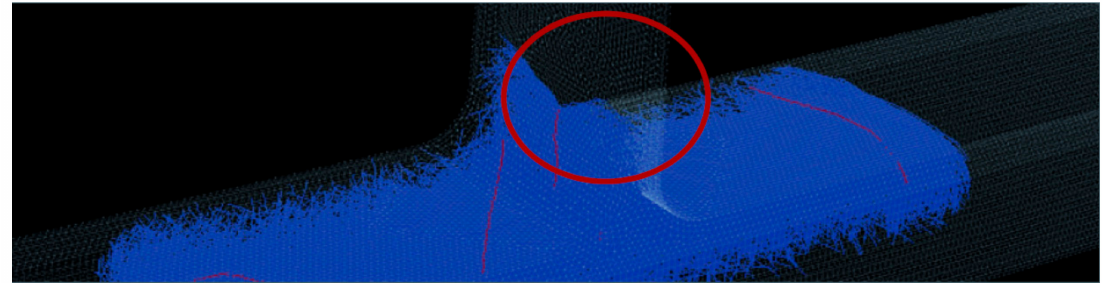
Figure 4. The circled frozen fiber in the center can be seen to stop other fibers from flowing past